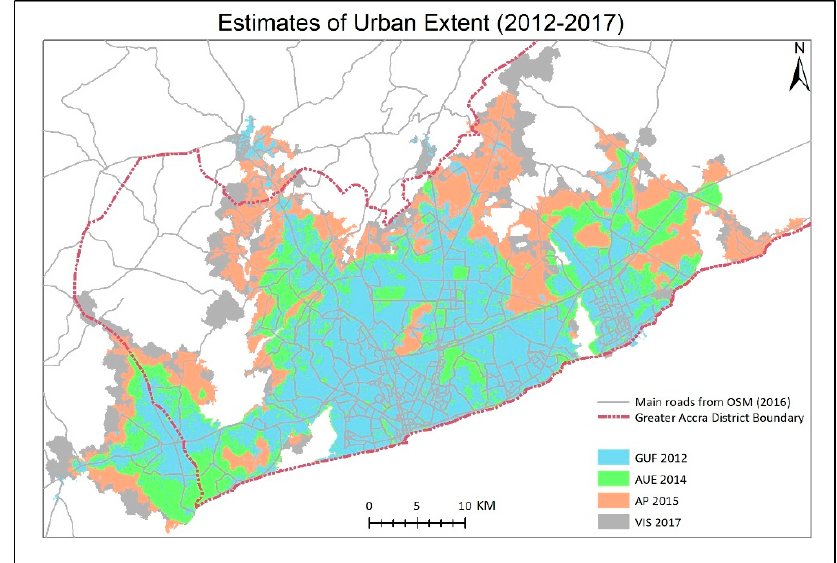
Figure 3. Estimates of the spatial extent of the Accra agglomeration for the most recent period (2012–2017). Contributing datasets: Global Urban Footprint (GUF), Atlas of Urban Expansion (AUE), AfricaPolis (AP) and Visual inspection of segments (VIS). Road network from OpenStreetMap 2016 (https: / www.openstreetmap.org).